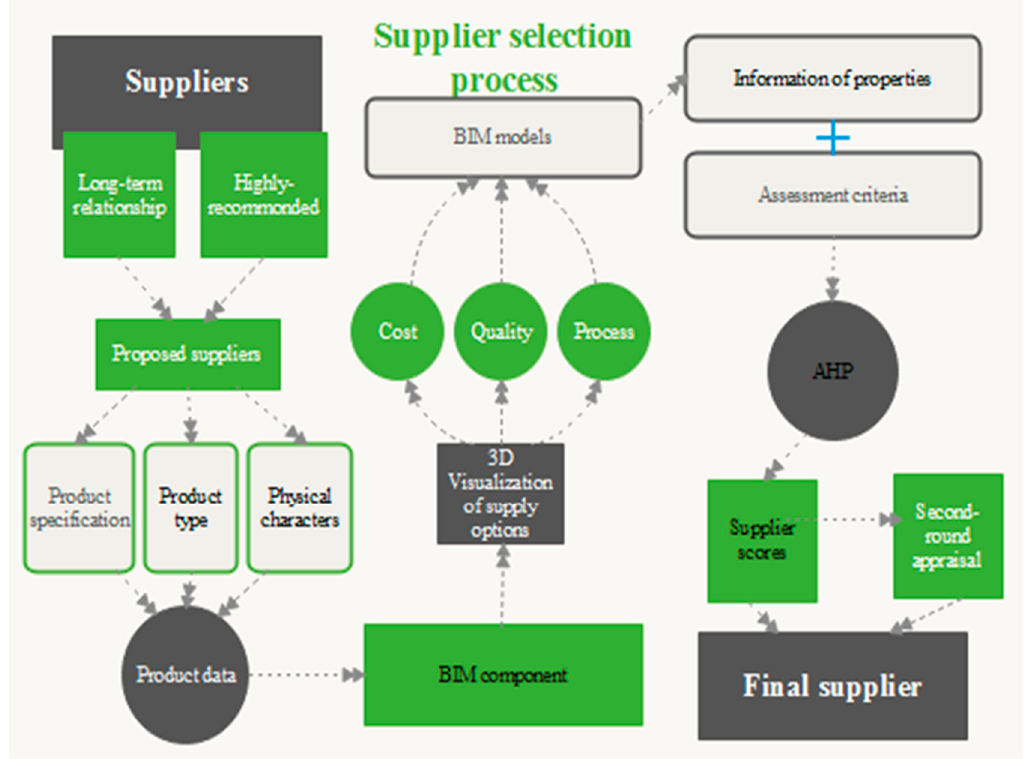
Figure 1. The assessment process using the proposed method.